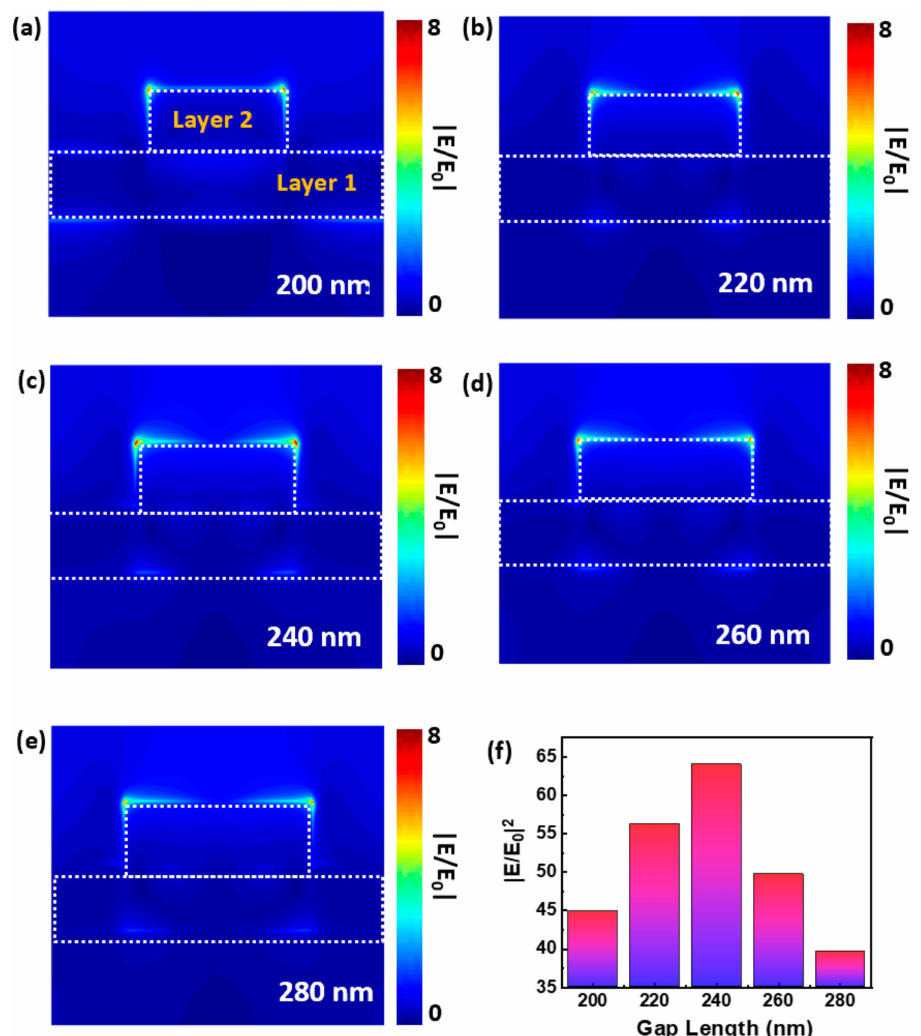
Figure 7. ( a – e ) Cross-sectional view of the simulated electric field distribution on the 10-nm Au nanogaps with selected gap lengths. ( f ) Calculated electric field enhancement of the 10-nm Au nanogap as a function of gap